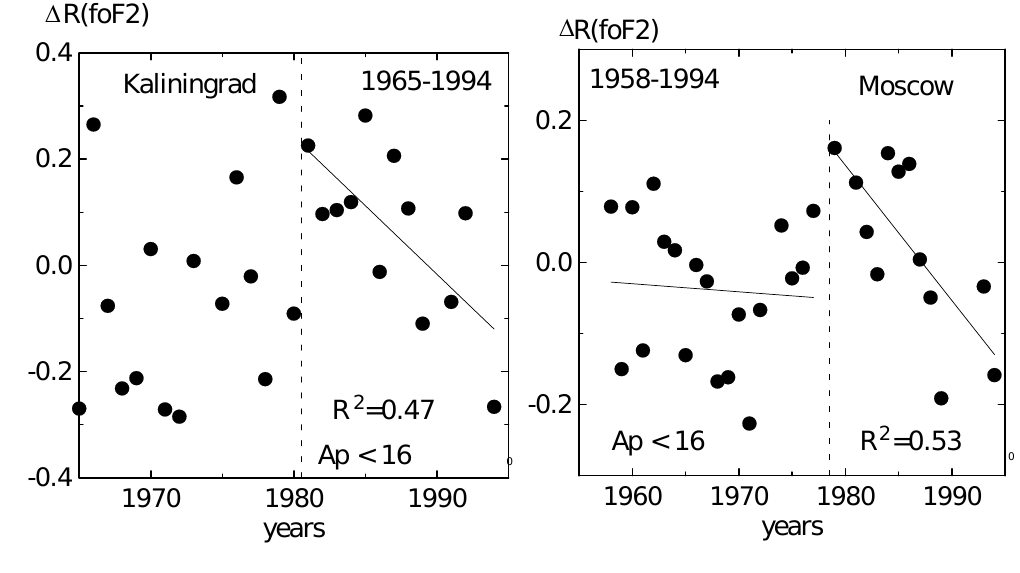
Fig. 6. Variations with time of 1R ( fo F2) for Kaliningrad and Moscow ( A p < 16).